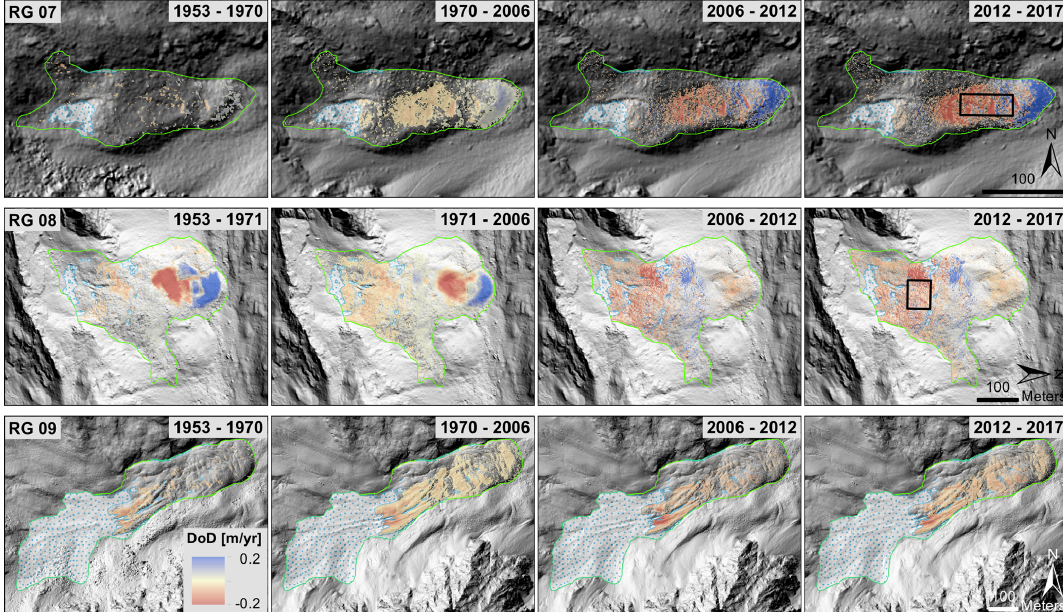
Figure 10. Mean annual surface elevation change maps for all individual rock glaciers and four epochs between 1953 and 2017. A LoD of twice the standard deviation of measurements in stable areas was applied for reasons of visualisation. The background image is a hillshade of the more recent DEM of the epoch. The white area with blue dots represents the snow mask. The black boxes in the maps of epoch 2012–2017 represent the respective subareas used for Fig. 11.